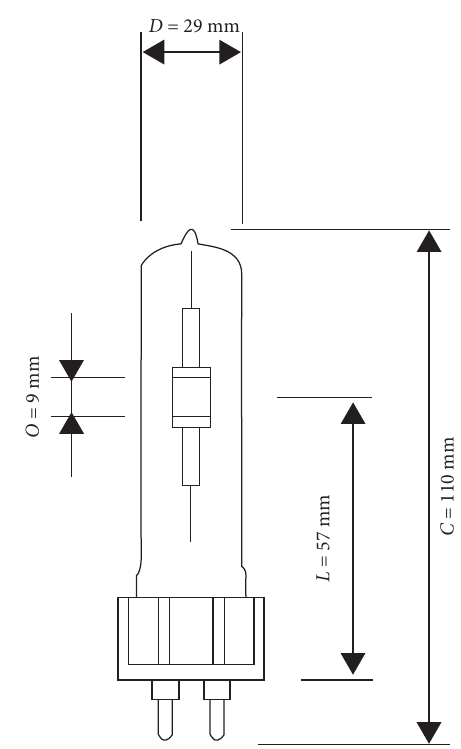
Figure 2: Structural specification of the Philips MASTERColour CDM-T Elite 150W/930 G12 1CT/12 bulb